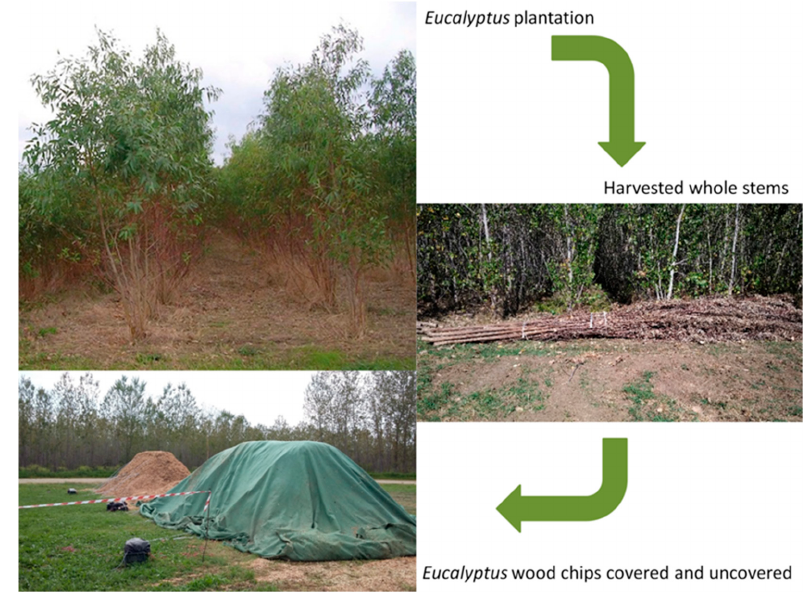
Figure 1. Experimental phases from field to storage site.